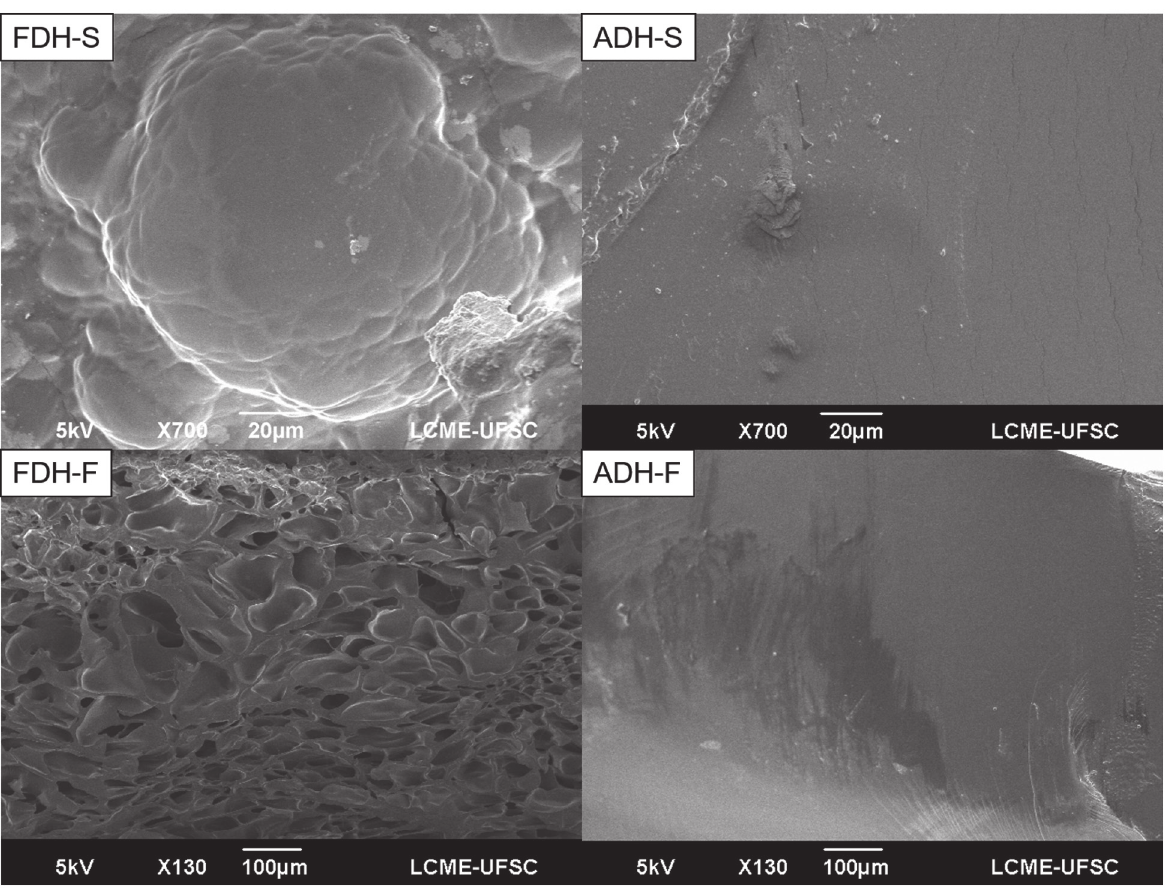
Figure 1 - Scanning Electron Microscopy images of: freeze dried gelatin hydrogel surface (FDH-S) and fragile fracture (FDH-F); air dried hydrogel surface (ADH-S) and fragile fracture (ADH-F). Magnifications: 700x surface and 130x